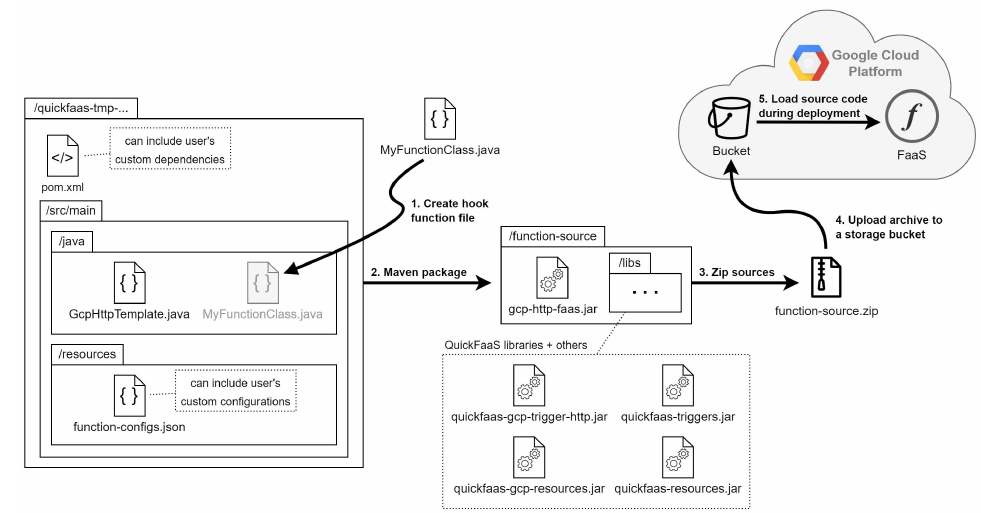
Figure 12. FaaS deployment to GCP for Java